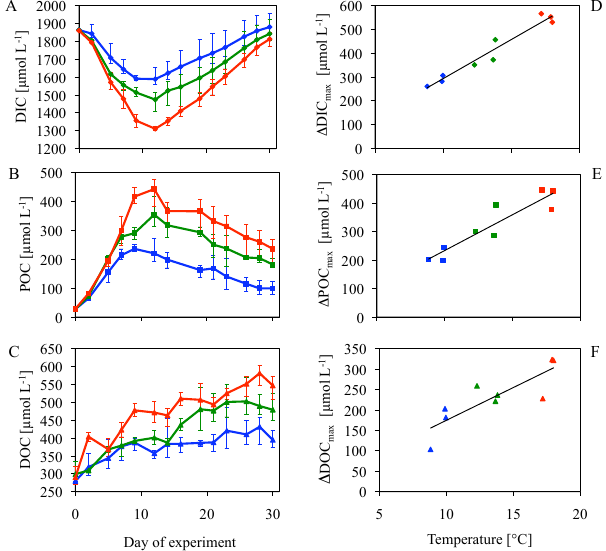
Fig. 3. Temporal development of measured concentrations of (A) DIC, (B) POC and (C) DOC. Style and color-coding follow that of Fig. 1. (D) Maximum drawdown in DIC, (E) maximum build- up of POC and (F) DOC as a function of temperature. Color-